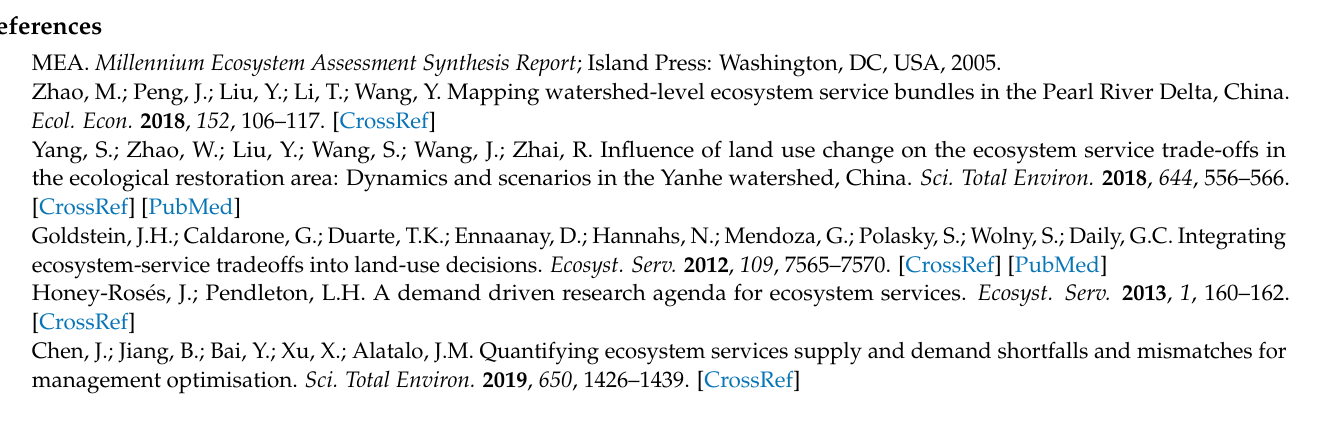
1: InVEST models; Table S4: Runoff Coefficients; Supplementary 2: InVEST parameterization and validation; Supplementary 3: Customized models; Table S5: LULC class definitions from NLCD 2001 and 2011, used in the maps for Kentucky; Table S6: The biophysical term of each ecosystem service; Table S7: Land use and land cover composition in each ecosystem service hotspots; Table S8: The number of overlap of ecosystem services hotspots; Figure S1: The observed data versus modeled data (kg ha-1 yr-1); Figure S2: Land use and land cover in